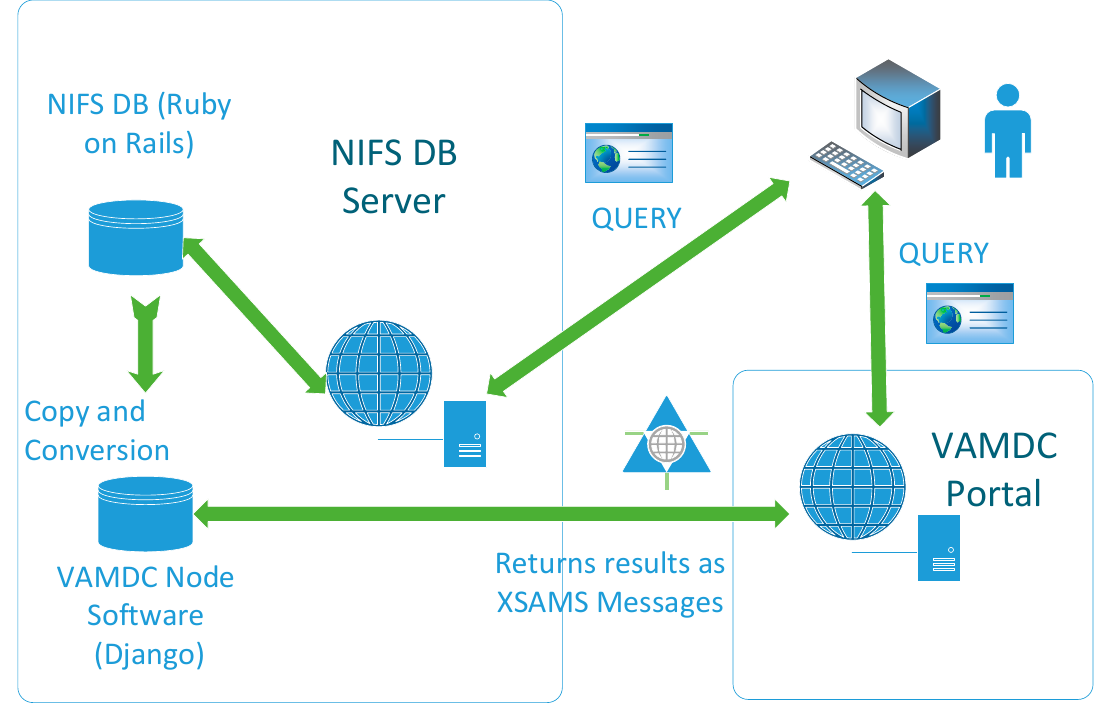
Figure 1. An overview of the new system. The contents of the NIFS DB are provided by the Ruby on Rails application. In order to communicate with the Virtual Atomic and Molecular Data Center (VAMDC) portal, VAMDC node software runs in the same server.